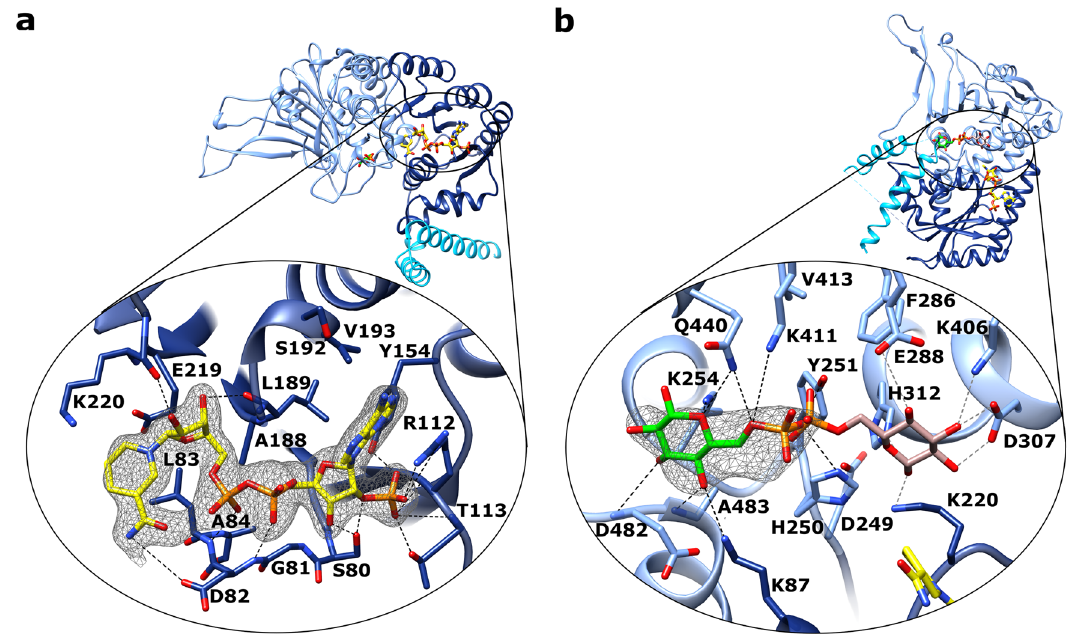
Fig. 5 Active site close-up of Ld G6PD. Ribbons and residues of the “ Rossmann-like ” domain are colored navy blue and of the β - α domain light blue. a Close-up of the NADP + binding pocket of the Ld G6PD structures (PDBID: 7ZHU) within the “ Rossmann-like ” domain. The NADP(H) moiety is colored yellow. Electron density map (F O -F C polder omit map) contoured at 4.0 σ for NADP(H), is shown in black. b Closeup of the G6P binding pocket. G6P is shown in two conformations. In brown, the G6P conformation from the superimposed Tc G6PD structure (PDBID: 5AQ1) with the pyranose ring pointing towards the NADP(H) moiety (yellow). In green, the G6P conformation of the Ld G6PD structures (PDBID: 7ZHZ). Electron density map (F O -F C polder omit map) contoured at 4.0 σ for G6P, is shown in black. Residues of the NADP + and the G6P binding pocket, are shown in stick models, and hydrogen bonds are indicated with black dotted lines or with gray dotted lines for the G6P moiety from the Tc G6PD